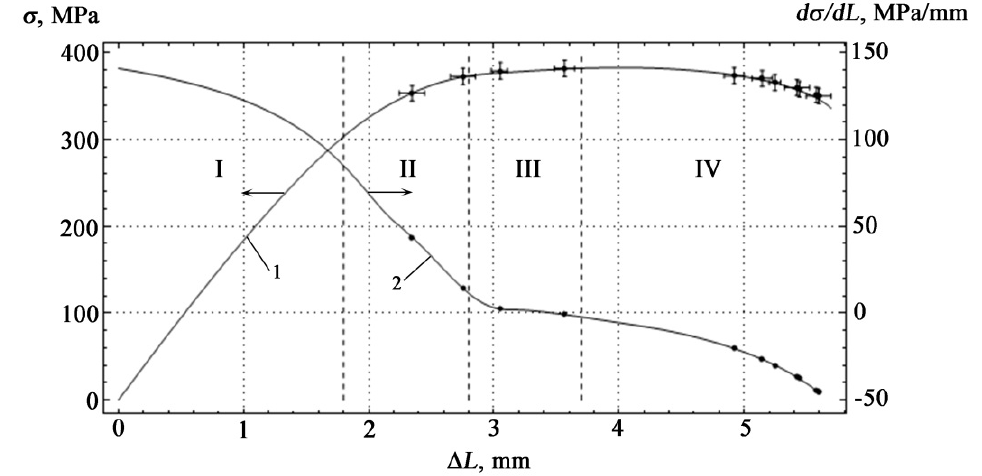
Figure 8. Dependence of mechanical stress (curve 1) and strain hardening coefficient (curve 2) on the deflection at four-point bending. Points on the graph show the moments of occurrence of AE signals, I–IV are the stages of strain hardening.